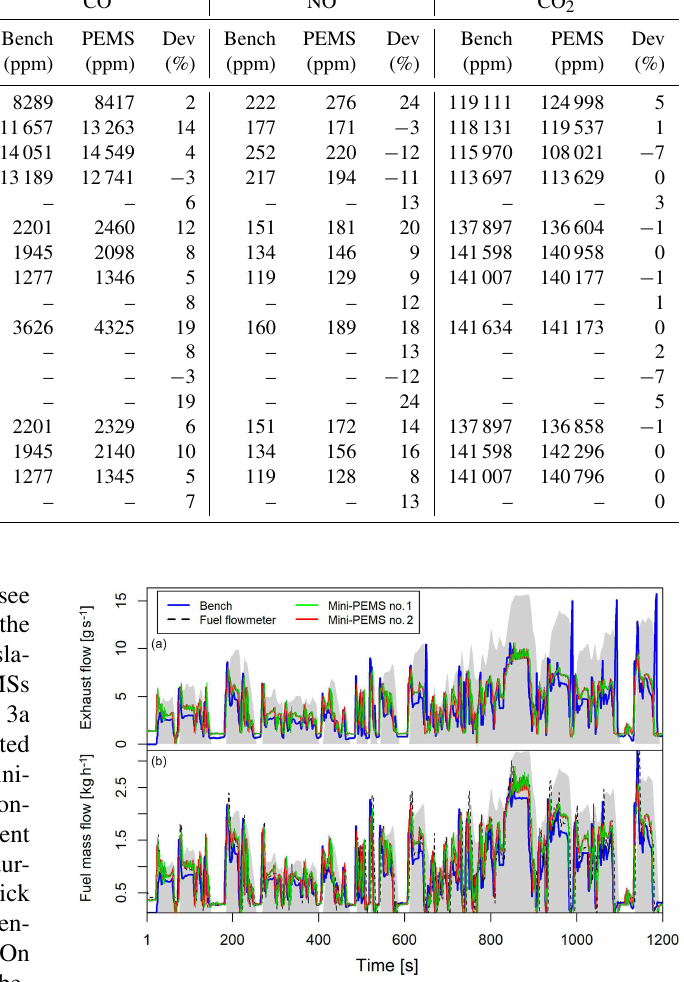
Figure 3. (a) Comparison of the exhaust flow from bench instru- mentation calculated with the CO 2 tracer method and from the two Mini-PEMSs during Test 5. (b) Comparison of fuel consumption (i) measured by a dedicated fuel flowmeter (KMA); (ii) calculated with the carbon balance method using HC, CO, and CO 2 mass emis- sions rates from bench instrumentation; and (iii) calculated from Mini-PEMSs No. 1 and No.